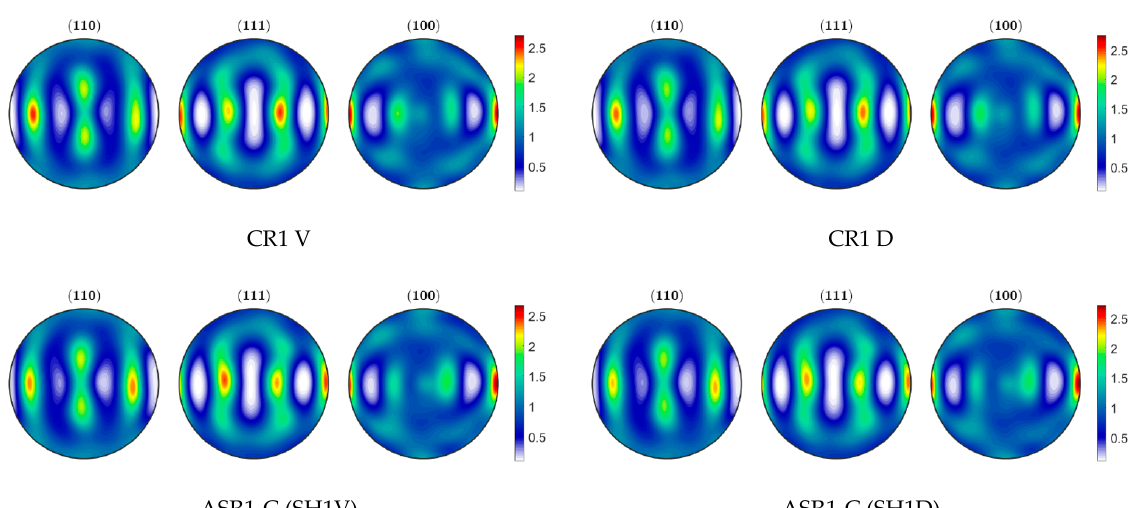
Figure A10. Cont